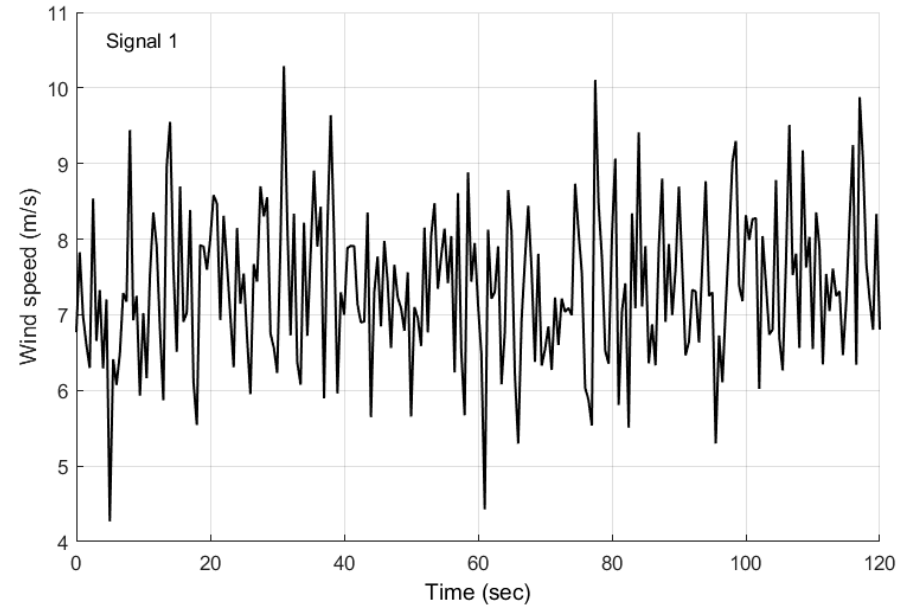
Figure 8. Wind speed distribution in the torque control region.